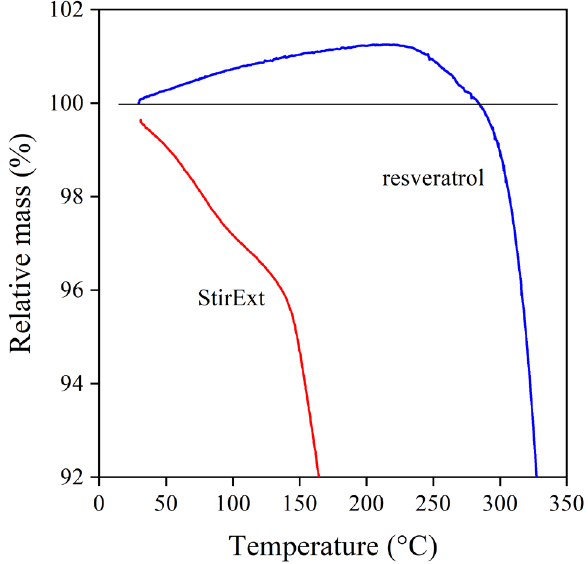
Figure 5. TGA traces of trans -resveratrol and the grape peel extract were produced in the stirred tank reactor. O 2 atmosphere; reaction of trans -resveratrol with oxygen.